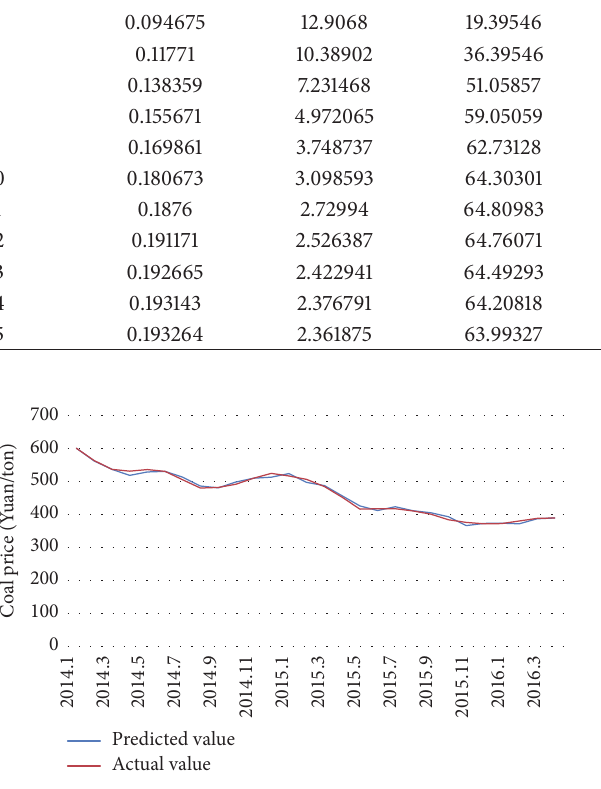
Figure 3: Predicted results of VAR model.